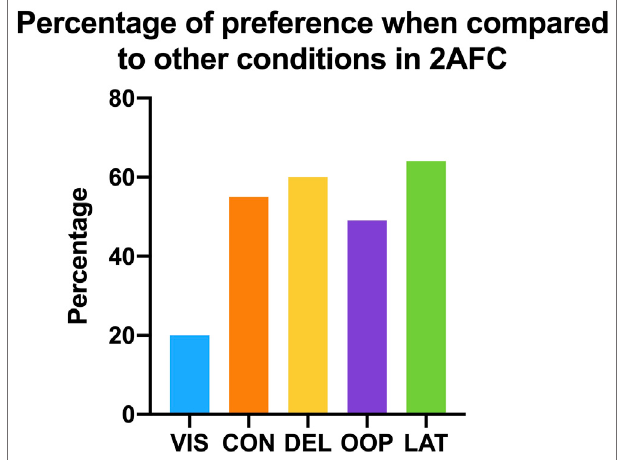
FIGURE 4 | Percentage of choice for each condition in the ten pairs of one-to-one comparisons in the two-alternative forced choice phase (30 participants for each ten comparisons). VIS, Visual-only condition (no vibration); CON, congruent condition; DEL, delayed condition; OOP, out-of-phase condition; LAT, lateralized condition.